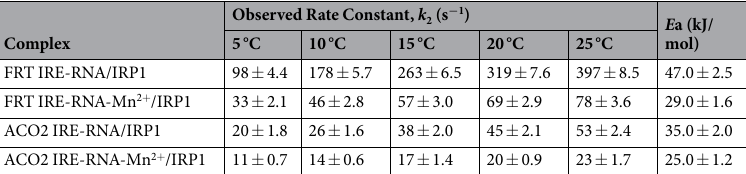
differences are comparable for the enthalpy change per hydrogen bond, Δ H B ~ − 13 kJ/mol, which is a typical value for hydrogen bonds 34 . This observation can serve as an indicator of decrease in hydrogen bonding for the IRE-RNA-IRP1 interactions with decrease in enthaply. Our enthalpy data is further supported by the free energy data for the contribution of hydrogen bonding between IRE-RNA and IRP1 protein. Addition of metal ion decreased binding free energy, Δ G , of about − 6.0 kJ/mol and the binding affinity for FRT IRE-RNA/IRP1 complex by 12-fold. Similarly, Mn 2 + decreased free energy, Δ G , of about − 5.0 kJ/mol and the binding affinity by 6-fold for ACO2 IRE-RNA/IRP1. This difference corresponds to the free energy difference of about 5–6 kJ/mol, which is a typical value of a single hydrogen bond or a salt bridge formed between a protein and RNA 35, 36 . This force (hydrogen bonding) contributes to the conformational stability of the molecule. IRP1 contains two binding pockets that make 22 bonds with IRE-RNA. The conversion of IRP1 from an aconitase to an IRE-RNA/IRP1